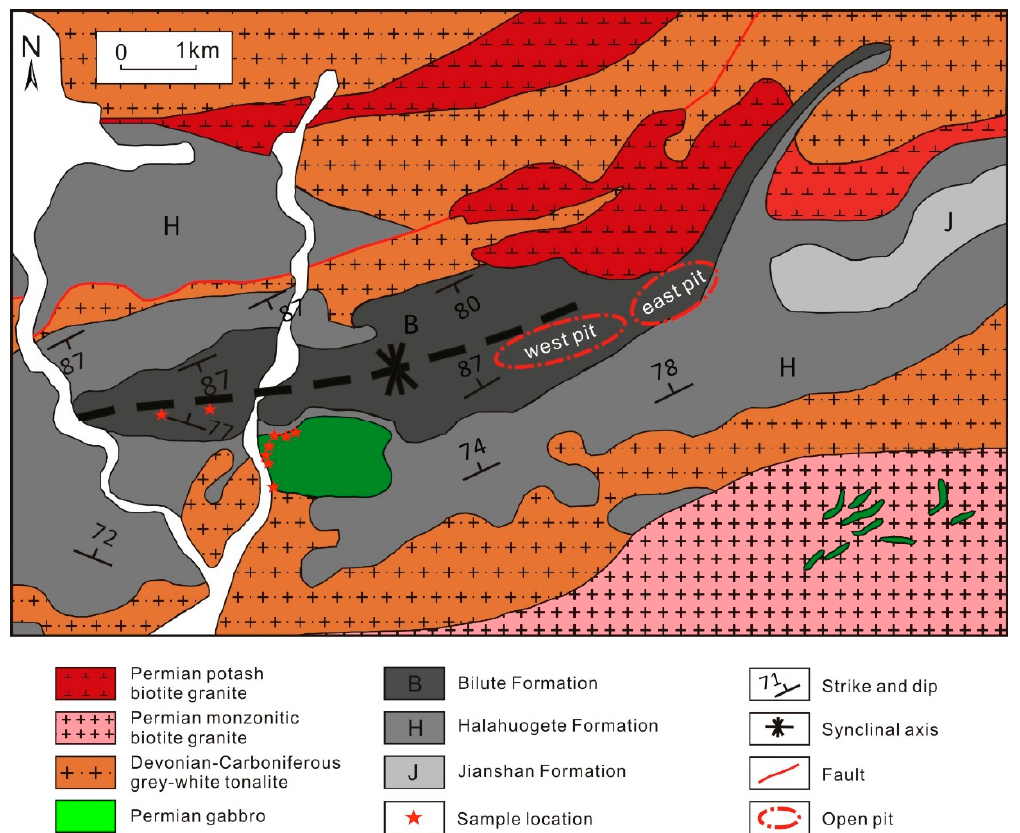
Figure 2. Geological map of the Haoyaoerhudong gold deposit showing the gabbro intrusion (modified after [14]).